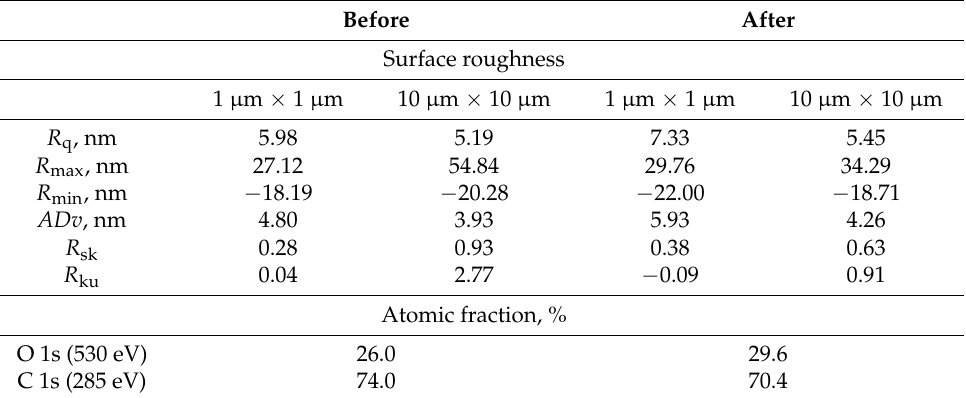
Table 2. Roughness characteristics, atomic fraction and chemical states of elements present in the top surface layer of polymer coatings deposited on the surface of PET substrata at 15 W before and after 60 s of plasma